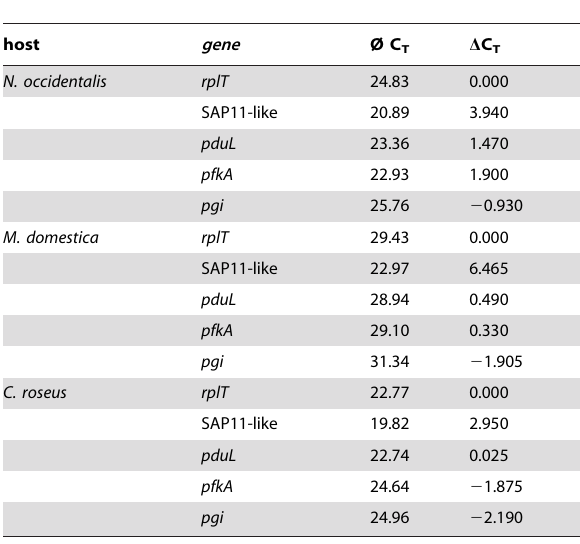
Table 3. Experimental hosts and genes used in qRT-PCR experiments with their correlating average (Ø) C T and D C T values after normalization (long